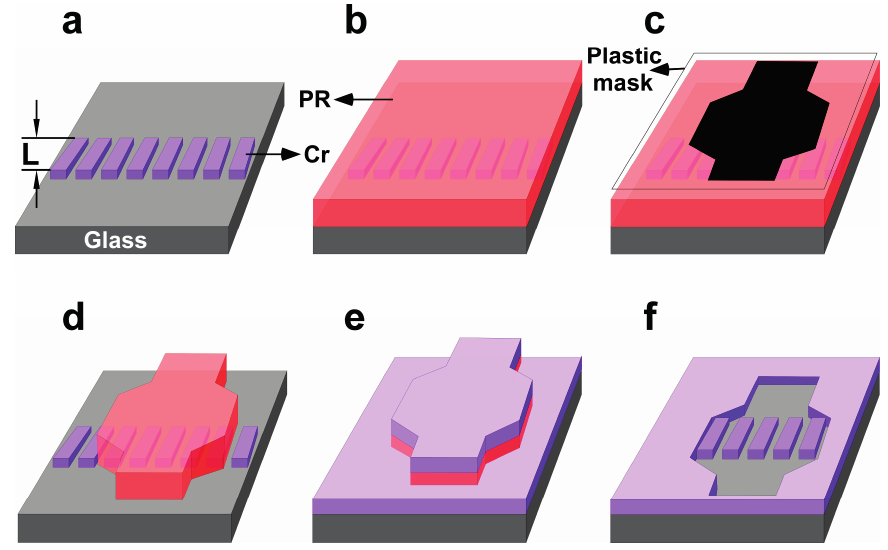
Figure 4. Incorporation of the array of microgaps ( a ) into a photomask to produce microfiltration masters for PDMS microfluidics. Following positive photoresit spin coating ( b ), photo-patterning with a plastic mask that defines the microfluidic channel ( c ) protects the microgaps ( d ) from Cr filling ( e ) until lift-off ( f ), which completes the formation of a high resolution, homemade, microfiltration